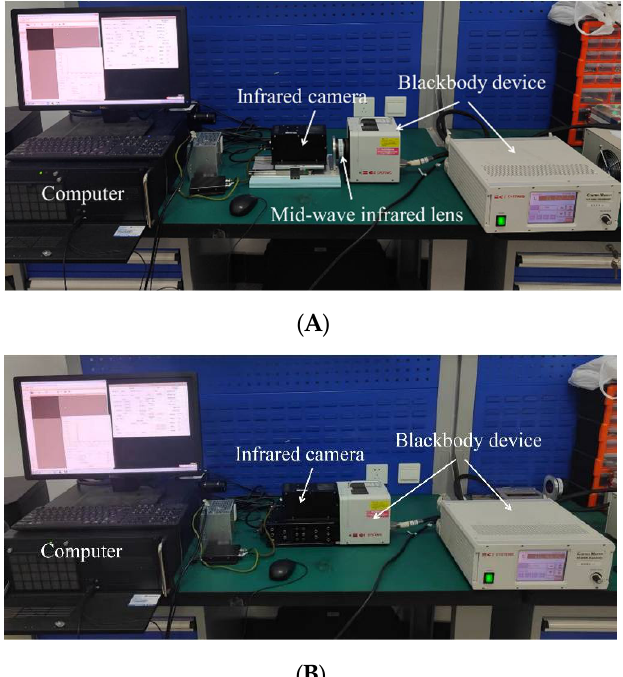
Figure 6. ( A ) Experimental setup for the calibration of the near-extended source (NES) blackbody. ( B ) Calibration experiment of the simulated baffle blackbody.